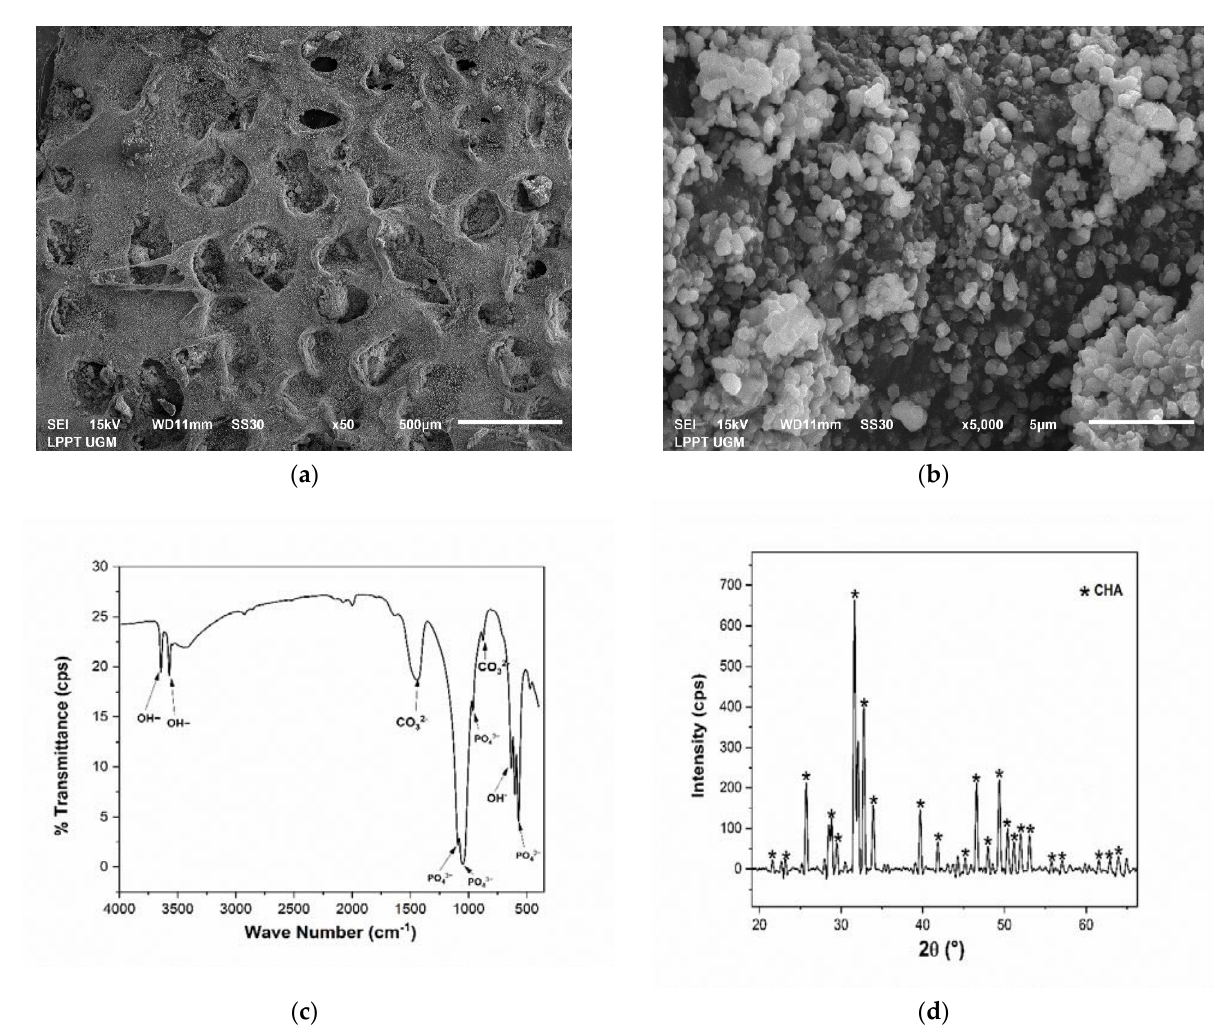
Figure 5. Physicochemical analysis of carbonated hydroxyapatite ‐ honeycomb composite: ( a ) macropore structure; ( b ) micropore structure; ( c ) FTIR spectra; ( d ) XRD pattern [33] .